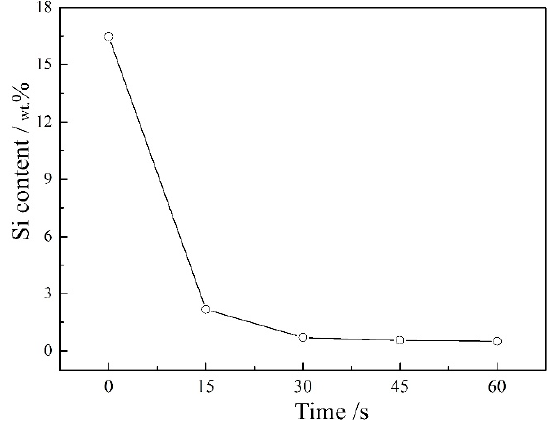
Figure 1. Si content on the surface of Al-12 Si treated by different etching times.